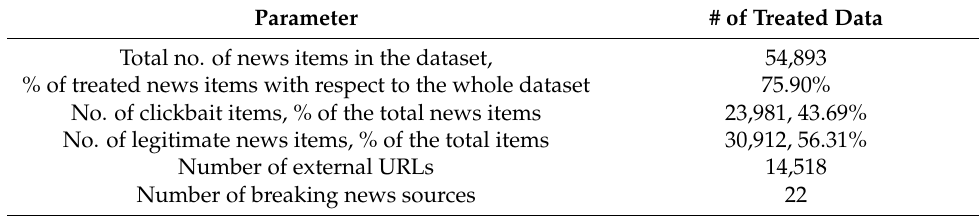
Table 6. Final dataset after applying PLL